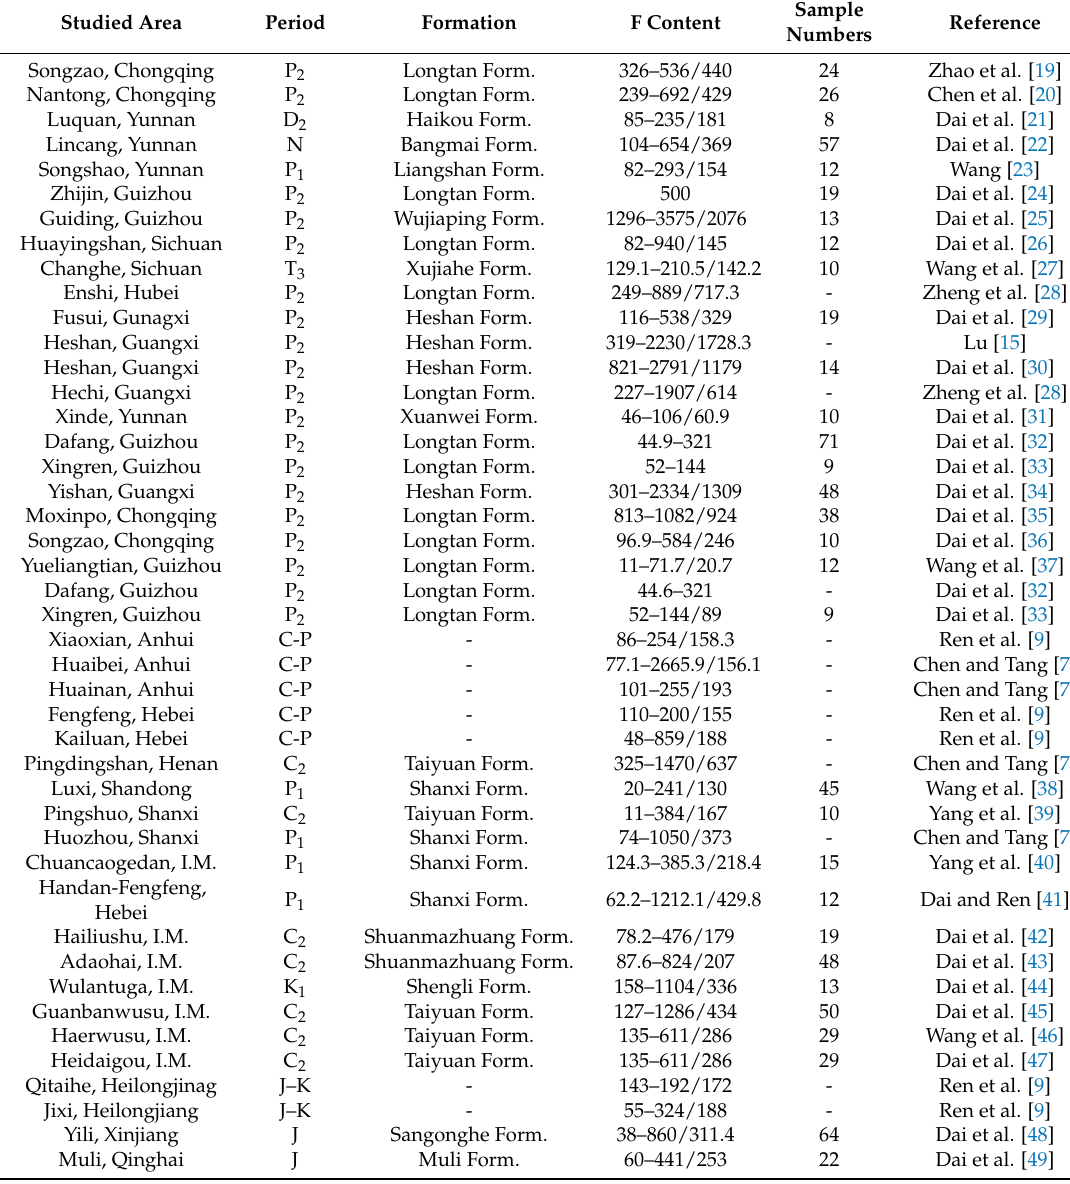
Table 1. Fluorine in Chinese coal (average of 130